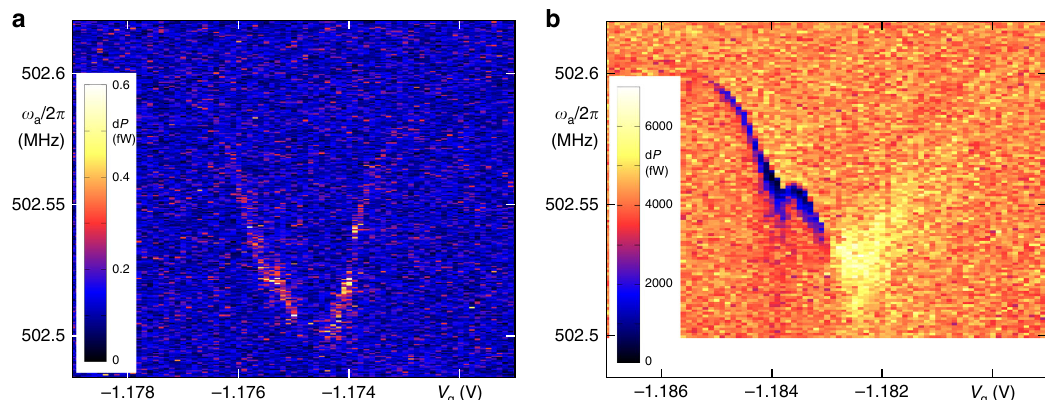
Fig. 4 Two-tone spectroscopy. Via an antenna, the carbon nanotube is driven at ω a close its mechanical eigenfrequency; the microwave cavity is simultaneously pumped at ω d = ω c − ω a . The plots show the power output of the cavity at the upconverted frequency ω c , with the nanotube acting as nonlinear element. Drive power P d = 20 dBm ( n c ≃ 2.1 × 10 4 ), measurement bandwidth 5 Hz. a Antenna generator power P a = − 55 dBm, bias V sd = 0; b antenna generator power P a = − 30 dBm, bias V sd =